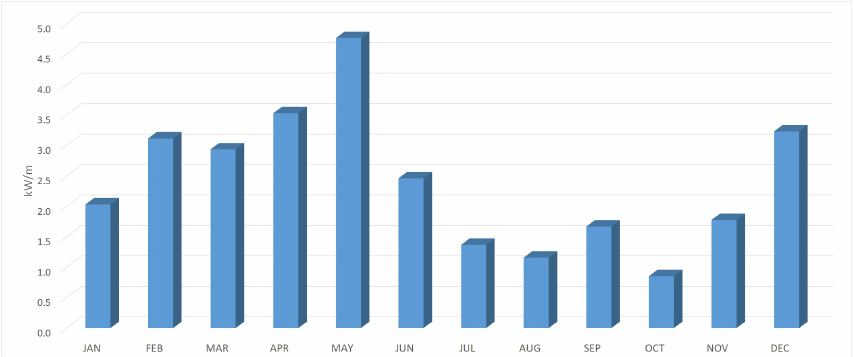
Figure 10. Monthly variation of wave energy in kW/m. Values presented are wave energy averages calculated over all 56 nodes.